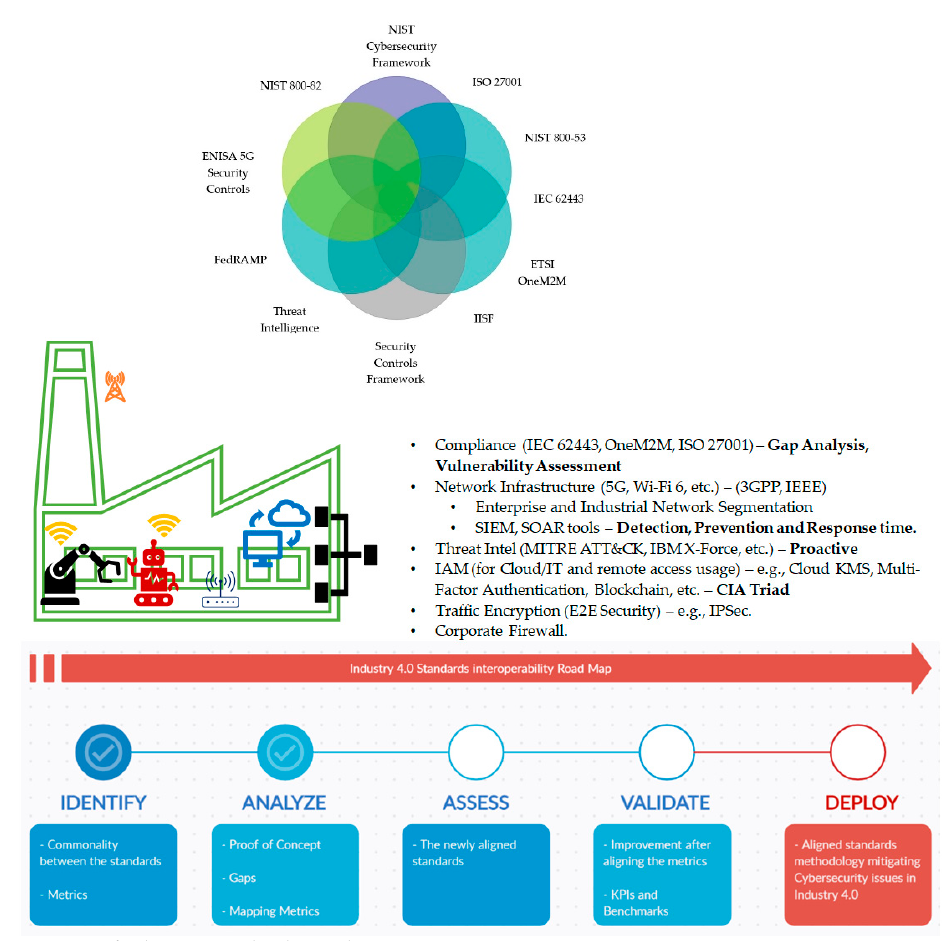
Figure 8. Unified IIoT standards roadmap.